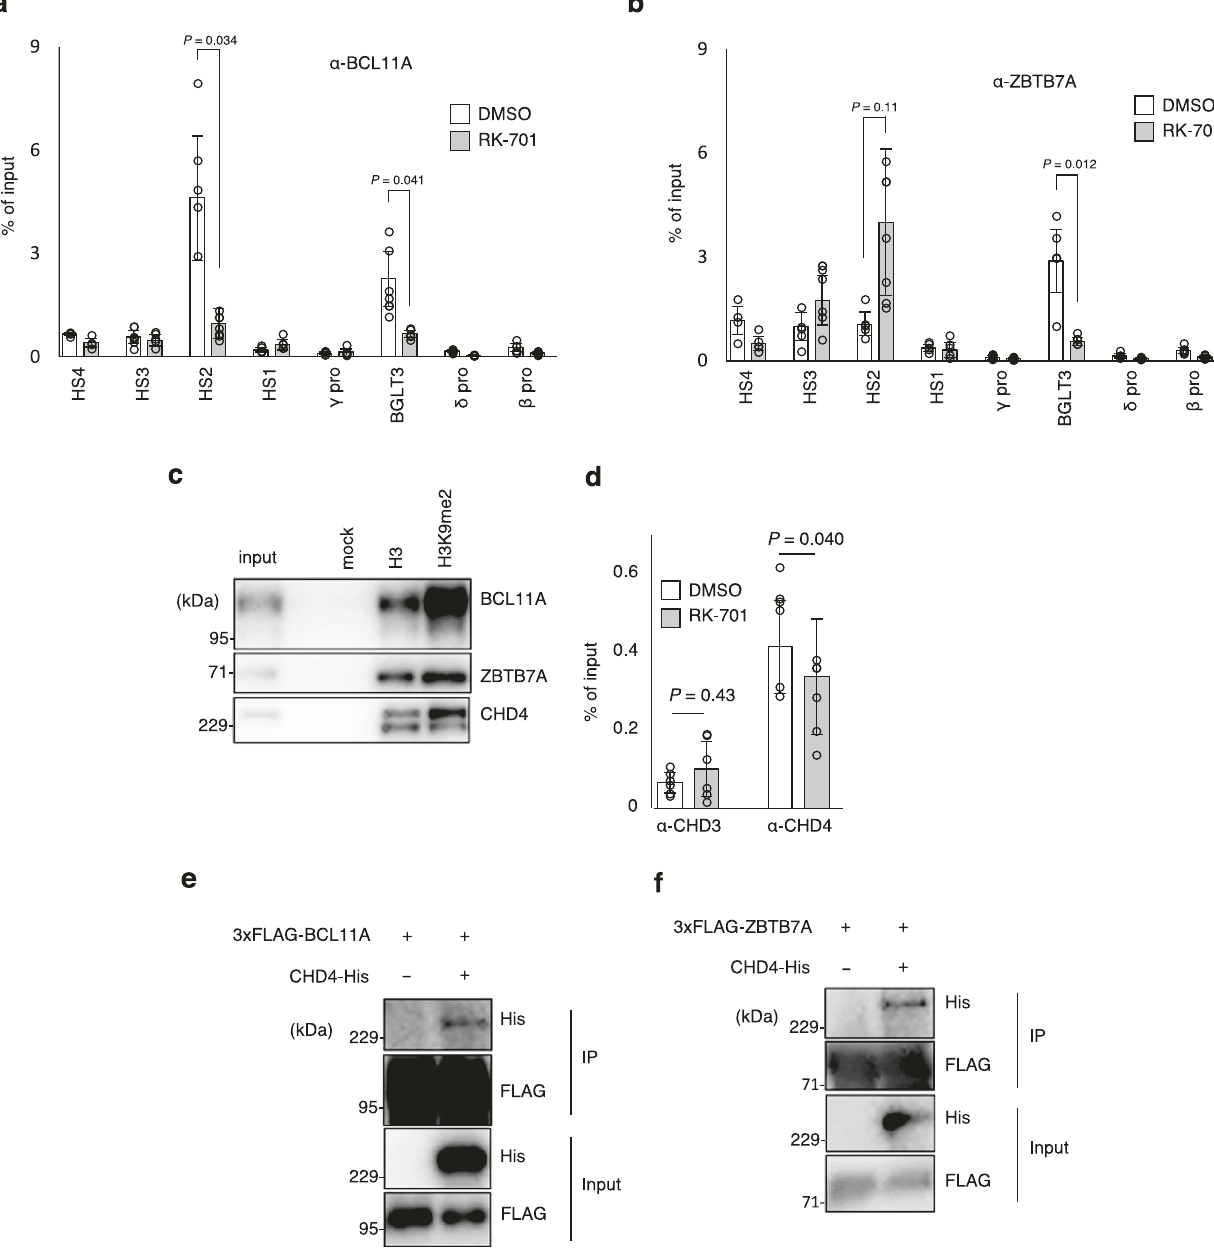
Fig. 5 | Regulation of occupancies of BCL11A and ZBTB7A at the BGLT3 gene locus by G9a. a , b ChIP-qPCR analyses using antibodies against BCL11A ( a ) and ZBTB7A( b )inHUDEP-2cellstreatedwith1 μ MRK-701orDMSOfor4days.Dataare mean±SD from three independent experiments. c Peptide pull-down assay with biotinylated histone H3 peptides from HUDEP-2 cell lysates. A Representative image of two independent experiments is shown. d ChIP-qPCR analyses using antibodies against CHD3 or CHD4 in HUDEP-2 cells treated with 1 μ M RK-701 or